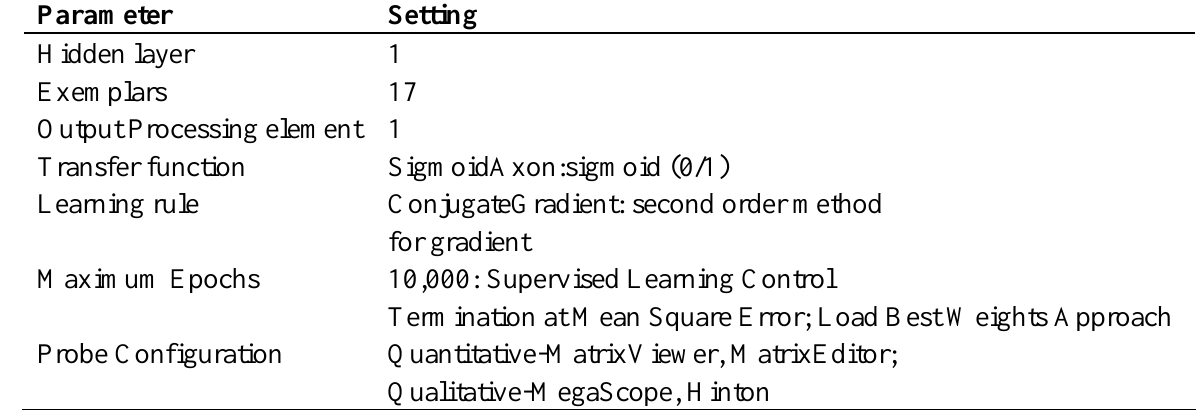
Table 3. Artificial Neural Networks construction parameters employing a neural